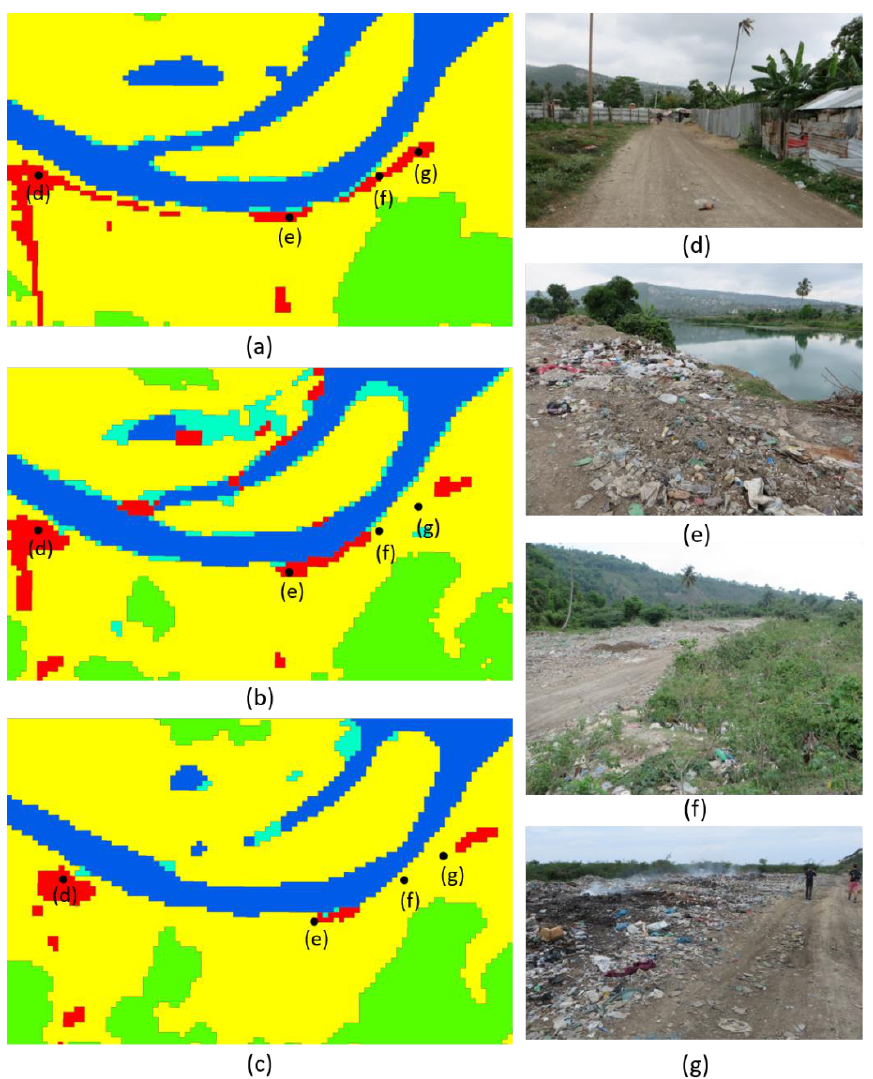
Figure 16. Right bank of the Grande Anse River, south of Jérémie: classification maps corresponding to ( a ) 2017, ( b ) 2018, and ( c ) 2019 (see Figures 7 and 8 and related legend), with indication of ( d ) dirt road leading to rural shacks and ( e ) unregulated and uncontrolled dump site, interspersed with ( f ) low vegetation and bush and where ( g ) garbage and plastic waste are also